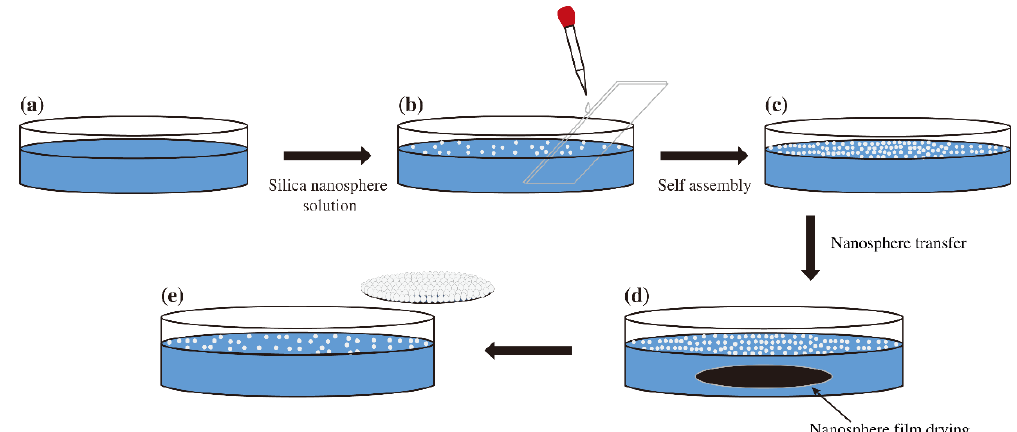
Figure 1. Main process flow of the dip-coating method.